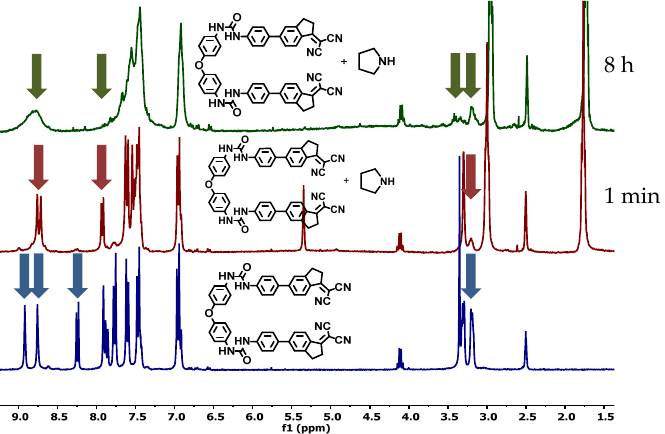
Figure 6. Evolution of the 1 H NMR spectrum of equimolecular solutions (2.5 × 10 − 3 M) of 1 + pyrrolidine in DMSO- d 6 .